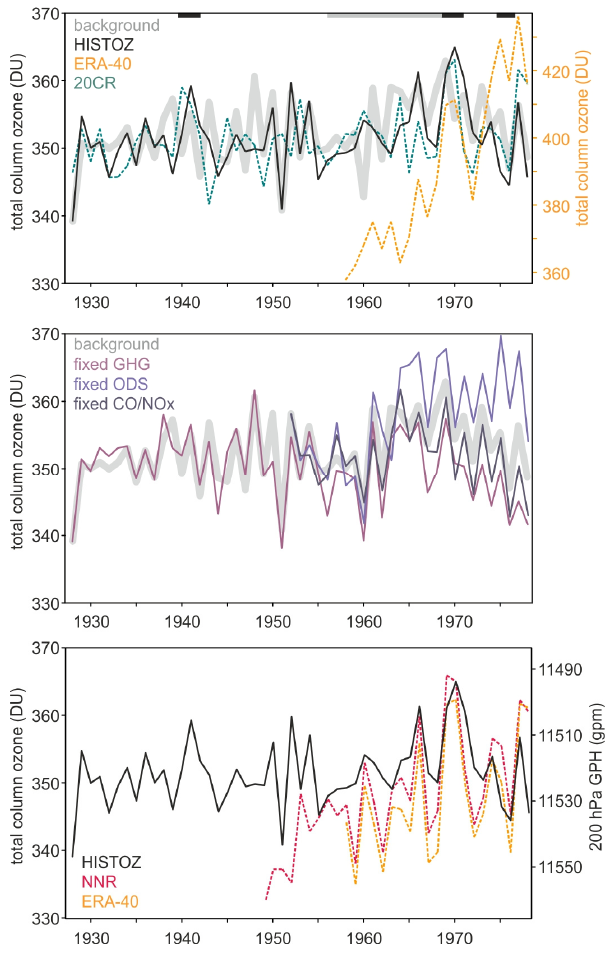
Fig. 9. (top) November-to-April averages of zonal mean total column ozone near 48 ◦ N in HISTOZ.1.0 (black), x b (thick light grey), 20CR (green dashed, scaled to match HISTOZ.1.0 in the 1958–1978 period), and ERA-40 (orange dashed). (middle) November-to-April averages of zonal mean total column ozone near 48 ◦ N in four SOCOL ensembles: all forcings simulations (i.e. x b , thick light grey), fixed greenhouse gas concentrations (fixed GHG, thin dark grey, scaled to match HISTOZ.1.0 in the 1928–1957 period), fixed ozone depleting substance (fixed ODS, purple) and fixed troposheric ozone precursors (fixed CO/NO x , dark olive). Bottom: November-to-April averages of total column ozone near 48 ◦ N from HISTOZ (black) and zonal mean 200hPa GPH (right scale, inverted) from different reanalysis data sets.